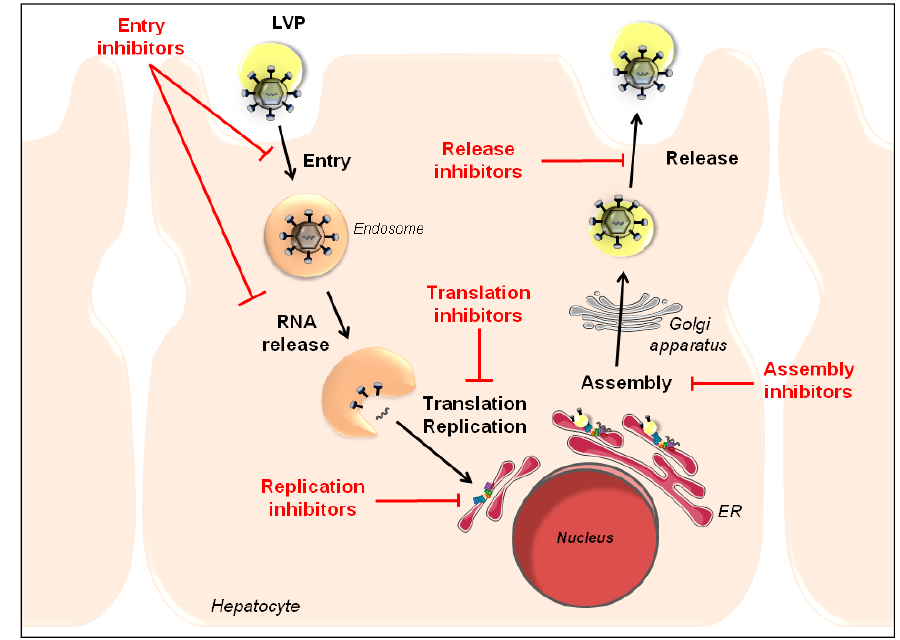
Figure 1. Schematic representation of the hepatitis C virus (HCV) life cycle and targets for antiviral therapy. HCV interacts with the basolateral membrane of hepatocytes, resulting in viral entry into the host cell. The virus is internalized via endocytosis and translation of the HCV RNA occurs in the cytoplasm following viral fusion and uncoating. Viral replication takes place within the cytoplasm in perinuclear endoplasmic reticulum (ER)-derived membranes called the “membranous web”. Progeny virions are assembled on cytosolic lipid droplets and subsequently transported along the secretory pathway and maturated in the Golgi before their release through microtubular transport and endocytic recycling compartment. Targets for antiviral therapy are highlighted in red.